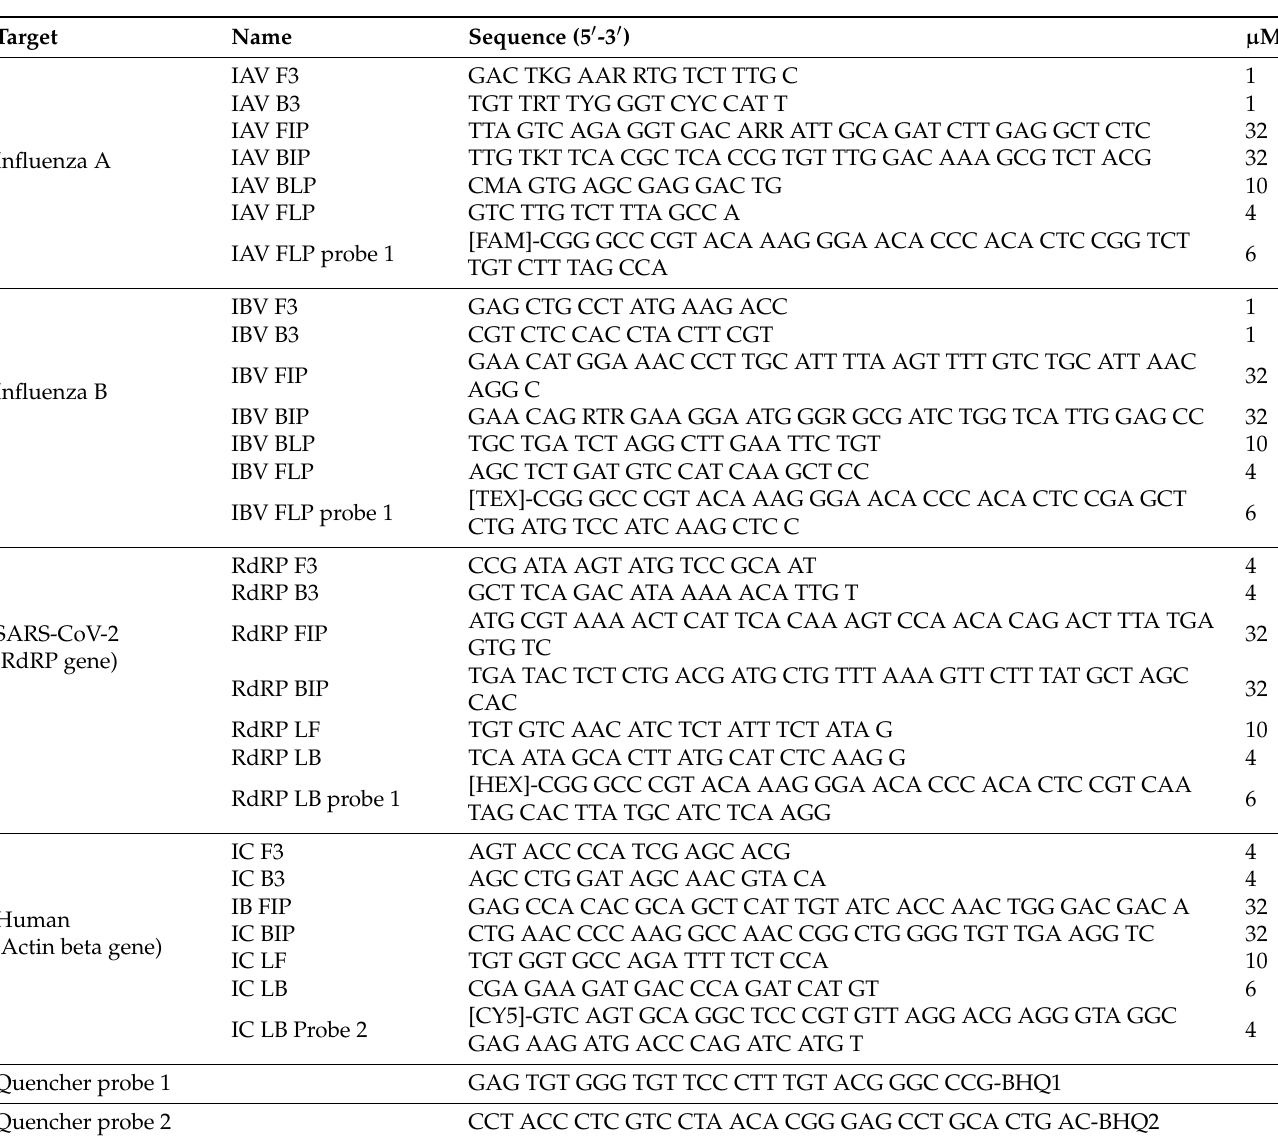
Table 1. The FluA/FluB/SARS-CoV-2 multiplex LAMP assay primer sets used in this